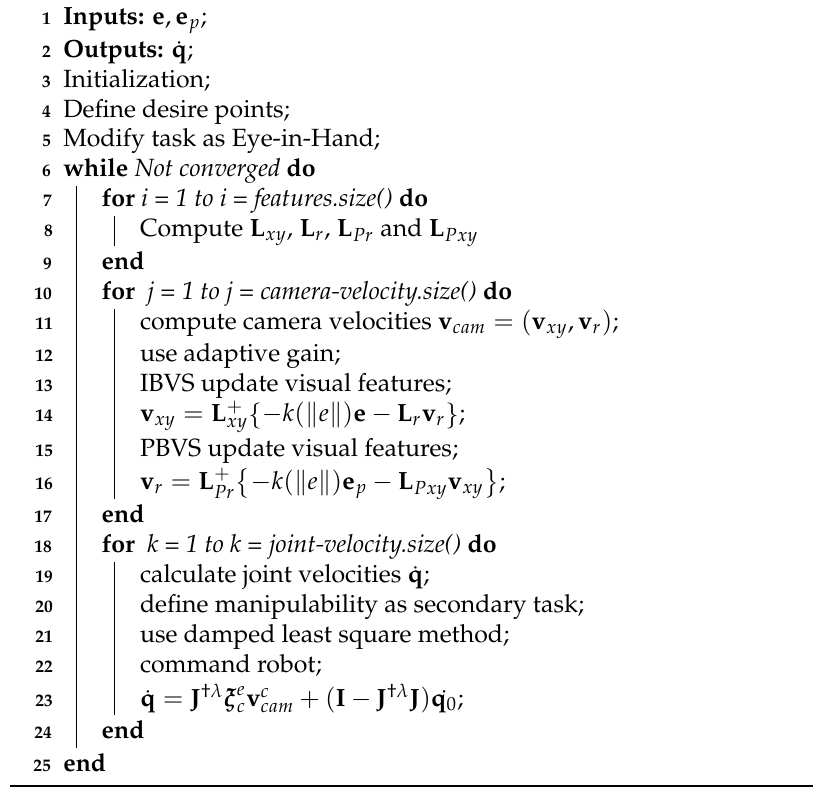
Algorithm 1: Decoupled hybrid visual